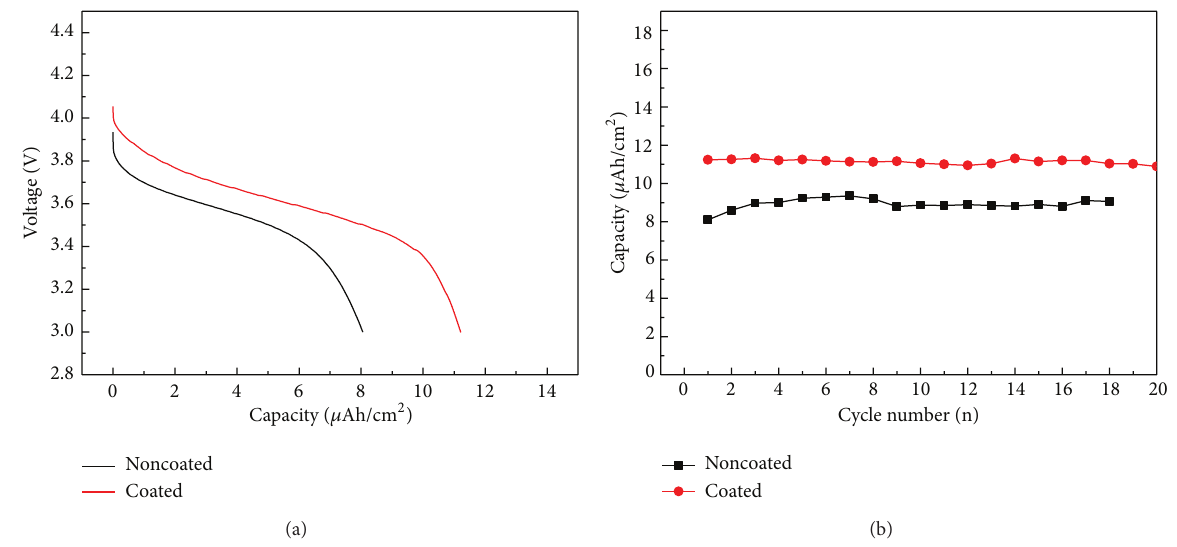
Figure 6: (a) Initial discharge behavior and (b) cyclic performance of LiNiO 2 thin films. The films were annealed in 10min at 500 ∘